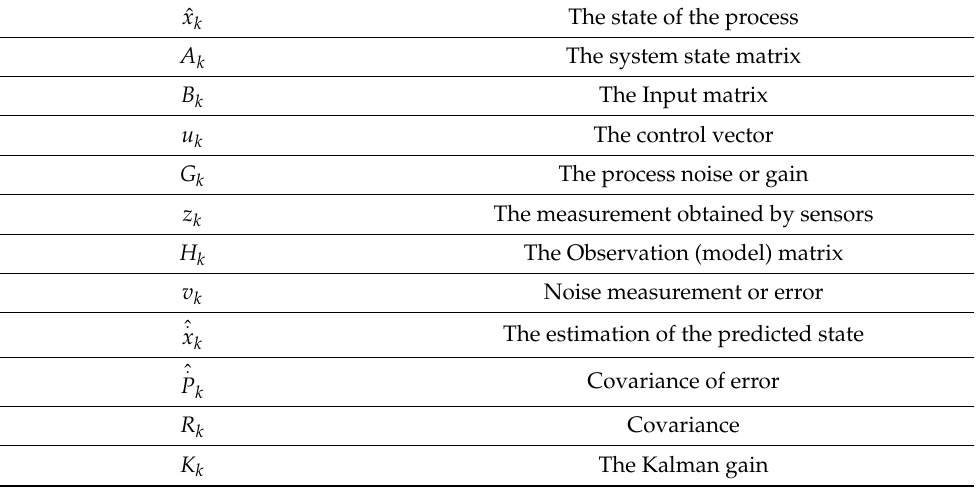
Figure 2. ( a ) The intersection of the covariance of data. ( b ) The gaussian PDFs of the estimation and measurement. Table 1. The notations used in